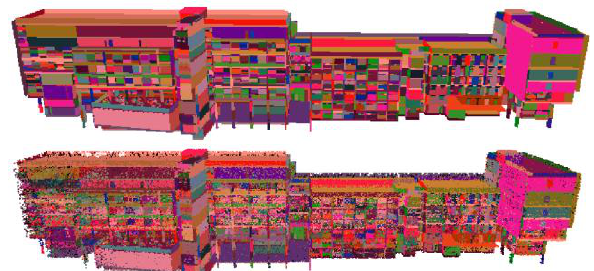
Figure 7 . Rendering voxels as point clouds; upper image shows all voxels as points; lower image shows some randomly culled voxels based on the distance to a camera Figure 5 . Mesh simplification of a voxelised model; upper image shows all triangles representing voxel visible faces; lower image shows simplified mesh.